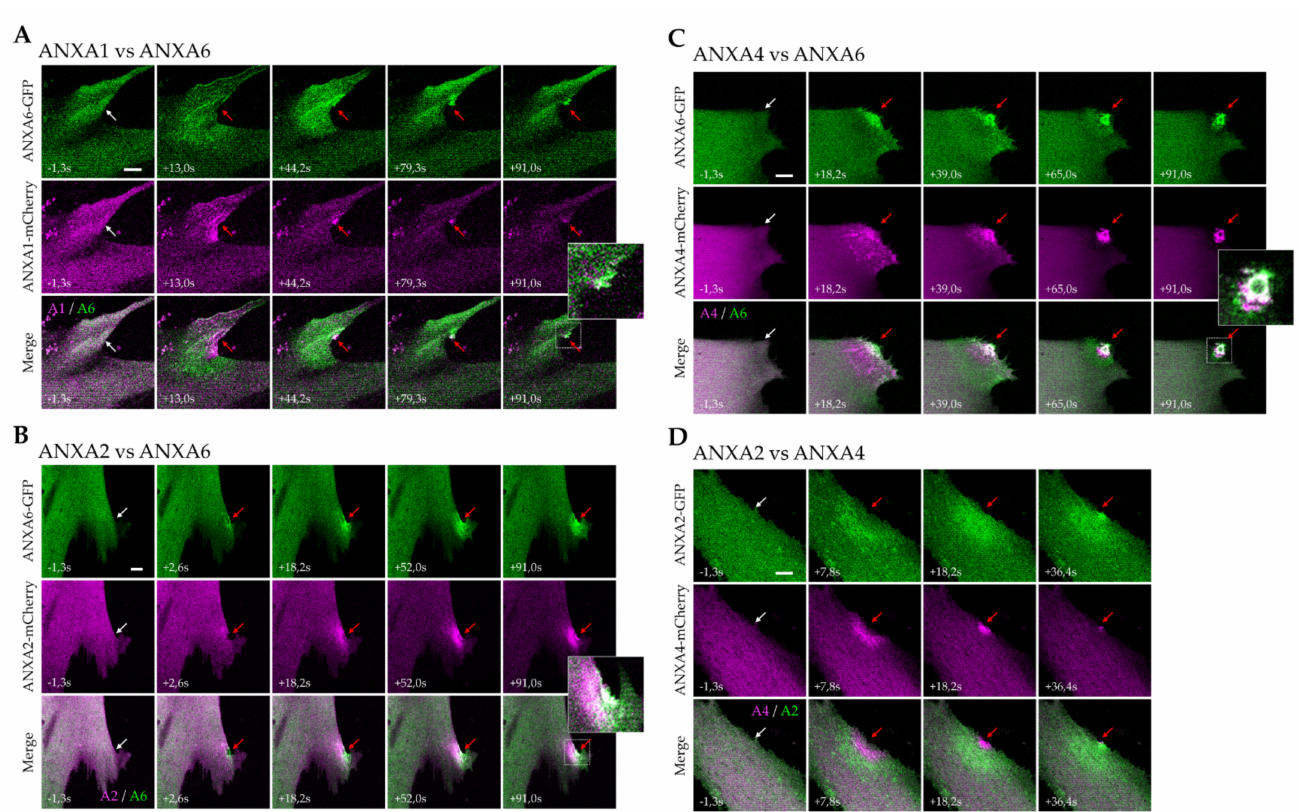
Figure 3. Comparative analysis of the recruitment of ANX to the site of membrane injury. ( A ) ANXA1 vs. ANXA6, ( B ) ANXA2 vs. ANXA6, ( C ) ANXA4 vs. ANXA6, and ( D ) ANXA2 vs. ANXA4. Myotubes were transfected with the plasmid pA1-mCherry, pA2-mCherry (or pA2-GFP for D), pA4-mCherry and pA6-GFP, as indicated. Membrane damage experiments were performed by laser ablation. White arrow, area before irradiation; red arrow, area after irradiation. Insets display magnified images of the membrane disruption site. Scale bar: 10 µ